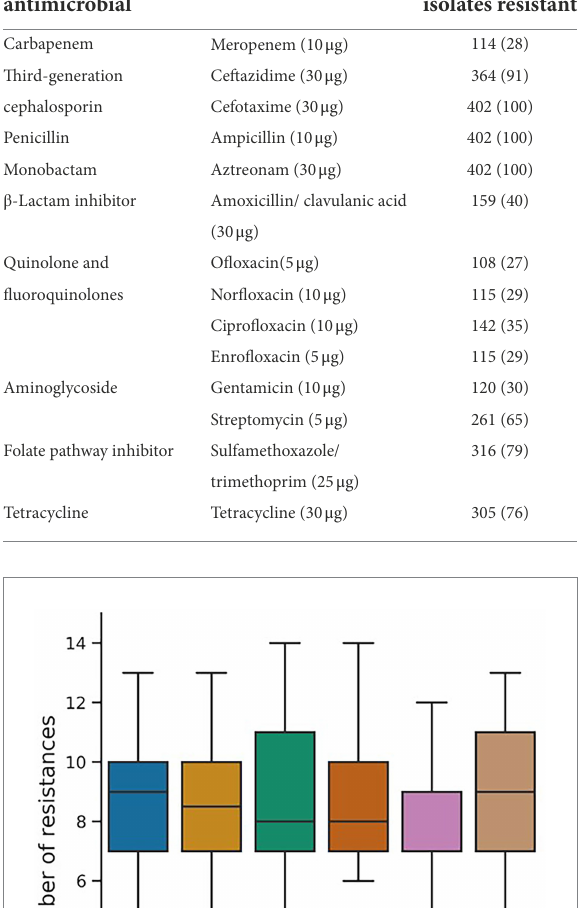
TABLE 1 Antimicrobial resistance profile of Escherichia coli isolates (n = 402) from livestock and in-contact humans in Southeast Nigeria. Class of Antimicrobial agent antimicrobial